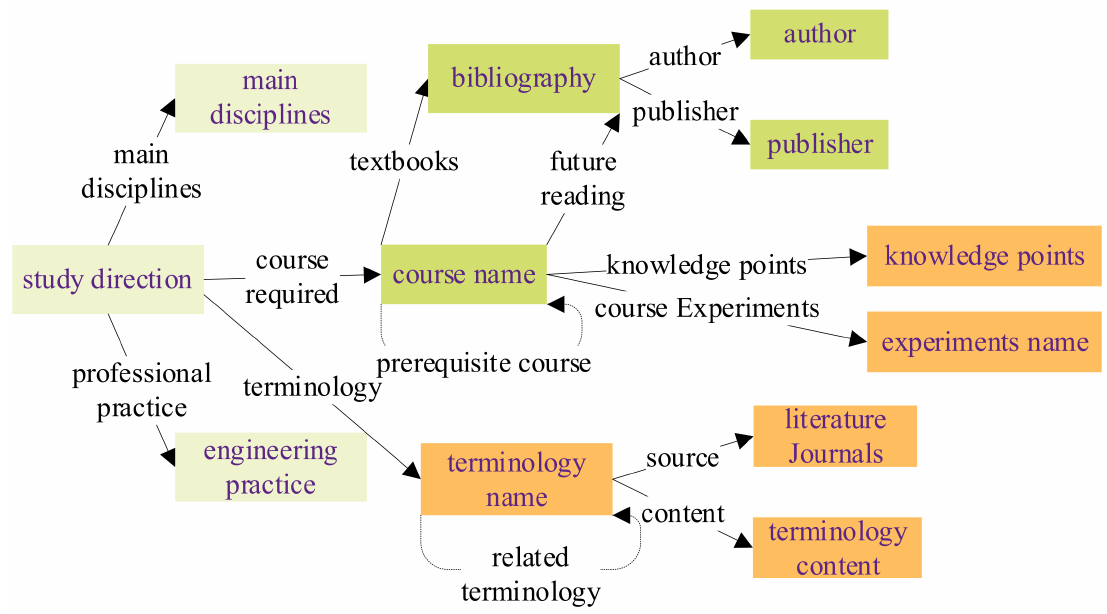
Figure 3. Ontology of water conservancy disciplines knowledge